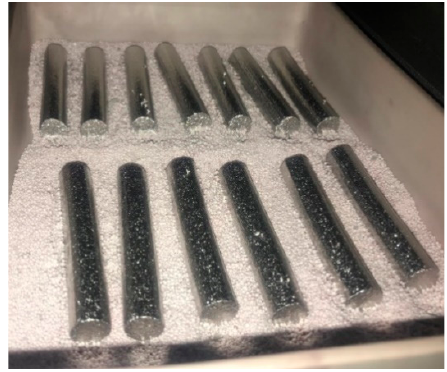
Figure 5. Sintered tensile test blanks.